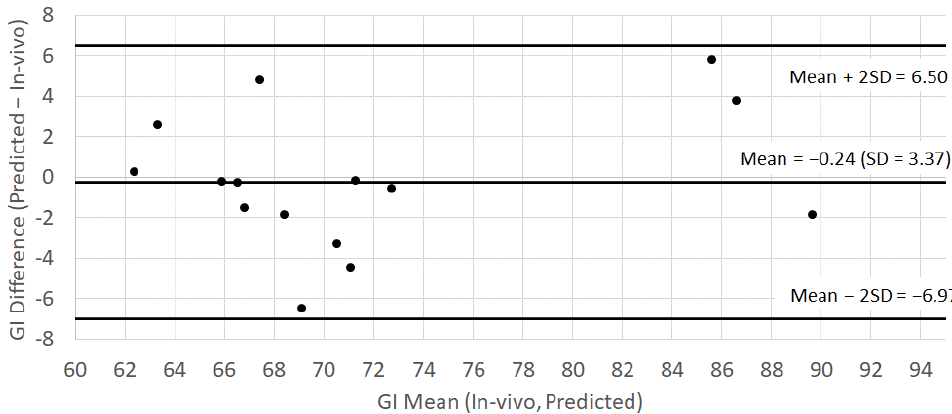
Figure 2. Bland–Altman plot comparing the in vivo GI estimates and eGI predicted from the nutritional composition of 15 samples, each of them being represented by a black dot (studies A, C and D).